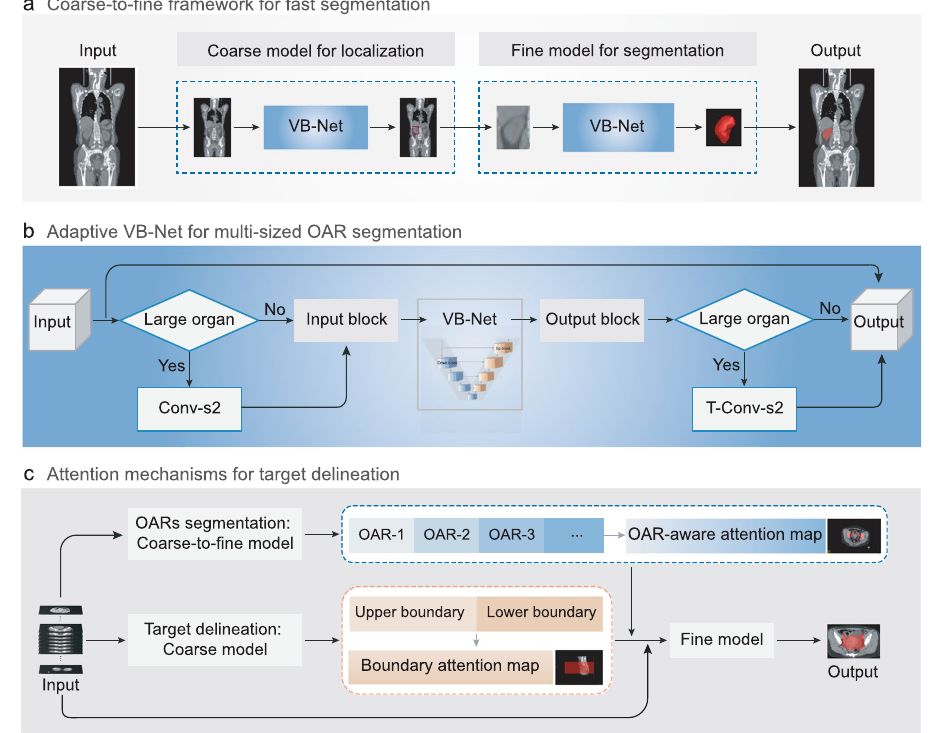
Fig. 2 | SchematicrepresentationsofRTP-Net for fast and accuratedelineation of organs-at-risk (OARs) and tumors. a Coarse-to- fi ne framework with multi- resolutions for fast segmentation. A coarse-resolution model is to localize the region of interest (ROI) in the original image (labeled in the red box), and a fi ne- resolution modelisto re fi ne the detailed boundariesof ROI. b Adaptive VB-Net for multi-sized OAR segmentation, which can be also applied to large organs. This is achieved by adding a stridden convolution layer with a stride of 2 (Conv-s2) and a